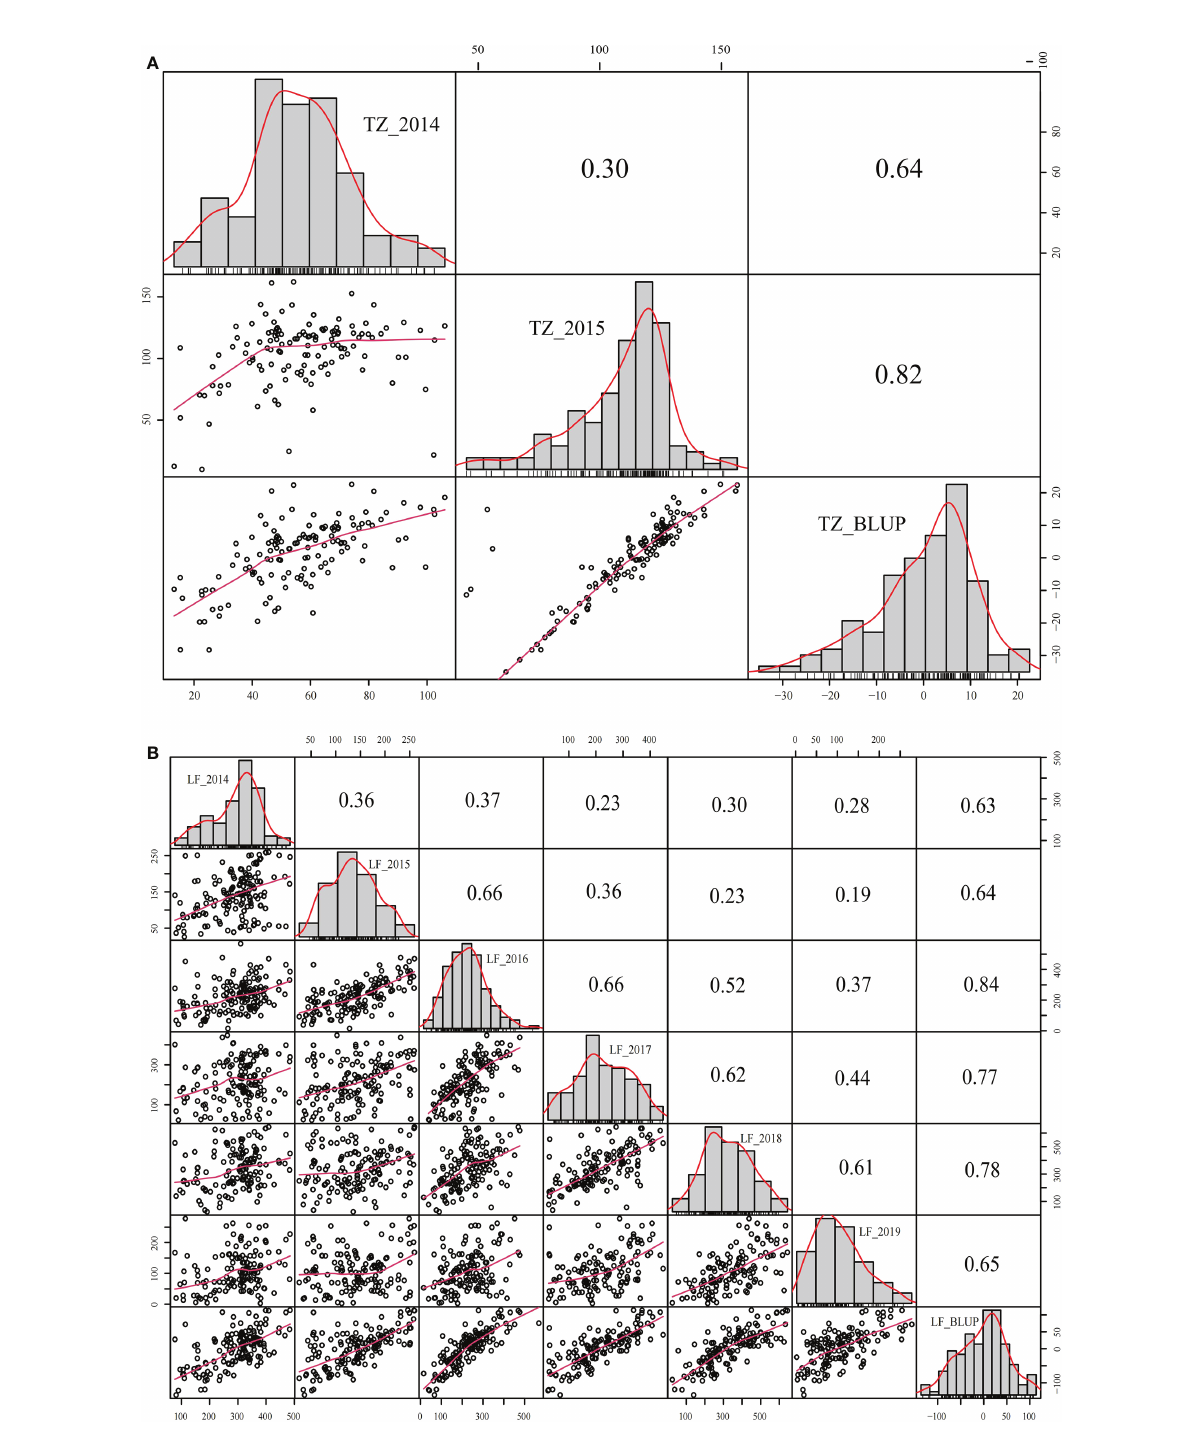
FIGURE 3 Correlation analysis of different years in the P149 population. (A) BLUP was calculated based on years in Tongzhou, Beijing. (B) BLUP was calculated based on years in Langfang, Hebei. BLUP, best linear unbiased